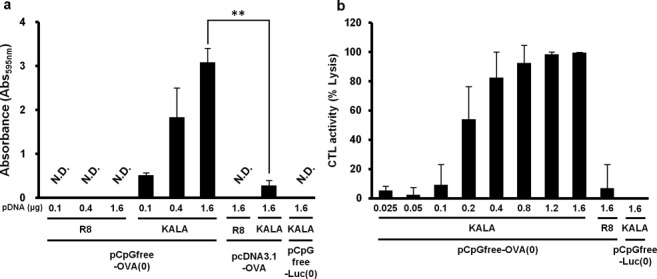
MHC class-I restricted antigen presentation and in vivo CTL assay. (a) BMDCs were transfected with pcDNA3.1-OVA, pCpGfree-OVA(0) or pCpGfree-Luc(0) (KALA-MEND only) by means of R8-MEND or KALA-MEND. Transfected cells were co-cultured with a B3Z T-cell hybridoma for 15 h at 37°C. The co-cultured cells were then incubated with chlorophenol red β-D-galactopyranoside buffer for 4 h at 37°C. The absorbance at 595 nm was used as an index for antigen-presentation activity. The absorbance observed in non-treated BMDCs was subtracted from each group. Data are mean ± SD of three independent experiments. Non-detected (N.D.)means under the detection limit. Statistical analyses were performed by the one-way ANOVA, followed by Bonferroni test. **P < 0.01 versus pcDNA3.1-OVA. N.S. means non-significance. (b) C57BL/6 mice were immunized with BMDCs transfected with KALA-MEND (encapsulating pCpGfree-OVA(0) or pCpGfree-Luc(0)) or R8-MEND (encapsulating pCpGfree-OVA(0)). CTL activities were measured 1 week after immunization. Data are mean ± SD of at least three independent experiments.